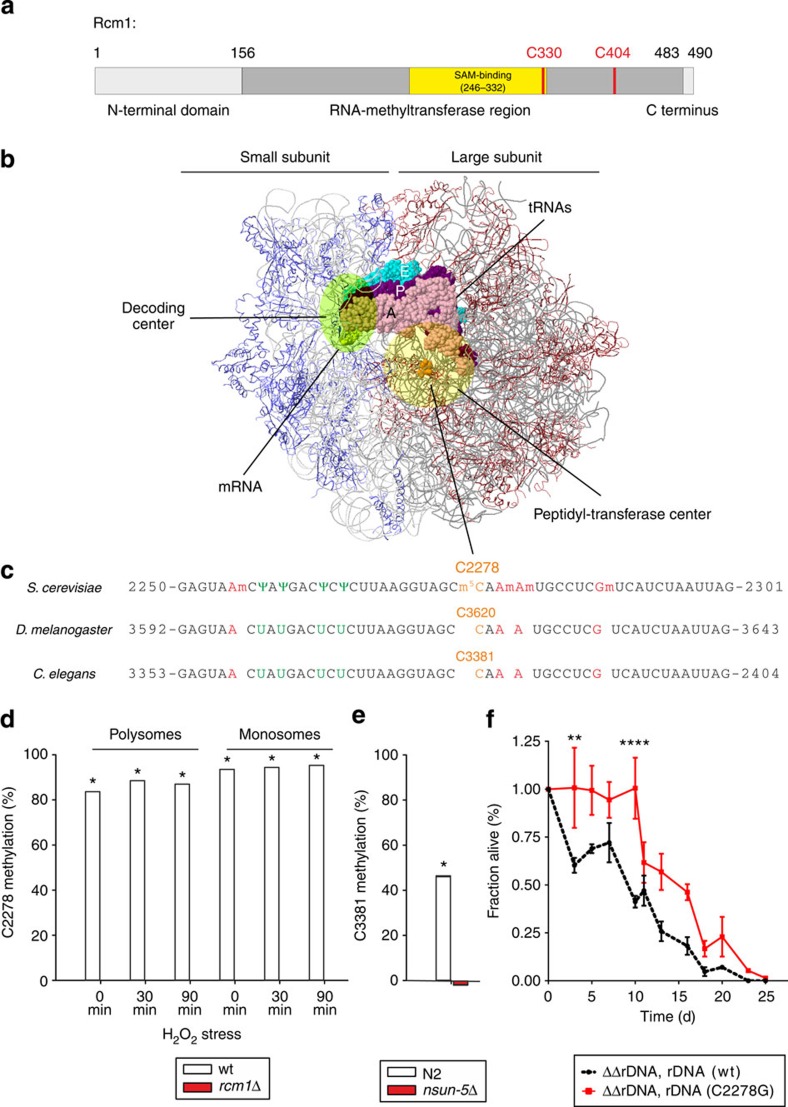
The conserved m5C-rRNA methyltransferase activity of Rcm1 mediates lifespan extension.(a) Rcm1 is a protein of 490 amino acids harbouring an RNA methyltransferase domain with two highly conserved cysteines, C330 and C404, which are predicted to participate in the catalysis of methyl transfer. (b) Model of the yeast ribosome with functional elements. The large and small ribosomal subunits, RPs of the SSU in blue and of the LSU in red, are shown assembled on the mRNA, the tRNAs in the aminoacyl site (A, pink), in the peptidyl site (P, magenta) and in the exit site (E, cyan) are depicted, and cytosine 2278 (C2278) of the 25S rRNA in vicinity of the peptidyltransferase centre is highlighted in orange. (c) 25S rRNA sequence tract, nucleotide 2251 to 2300, harbours a series of highly conserved modified nucleotides, pseudouridinylations in green and guanine and adenine base methylations in red, and the single m5C-methylation in orange. This region is 100% conserved from S. cerevisiae to C. elegans and D. melanogaster. (d,e) Bisulfite sequencing of wt yeast cells detects C2278 methylation in rRNA isolated from ribosomal fractions independent of oxidative stress. Deletion of rcm1 resulted in a complete lack of cysteine C2278 methylation under all conditions tested (d). Bisulfite sequencing of N2 wt C. elegans confirms conservation of C3381 m5C-methylation, while deletion of nsun-5 resulted in a complete lack of this modification (e). Displayed values represent fraction of C2278/C3381 methylation minus average fraction of unconverted Cytosines except C2278/C3381 as unspecific background. Grubbs’ Test at α=0.01 was performed on all Cytosines in the sample and asterisk * marks samples with C2278/C3381 identified as significant outlier. (f) Deletion of ribosomal DNA in haploid S. cerevisiae and rescue with unmethylatable rDNA (C2278G) on a plasmid increases chronological lifespan in SC compared with wt rDNA (wt). Error bars represent s.e.m. of three biological replicates (multiple comparison adjusted two-way ANOVA with Sidak post test, α=0.05, **P<0.01, ****P<0.0001).